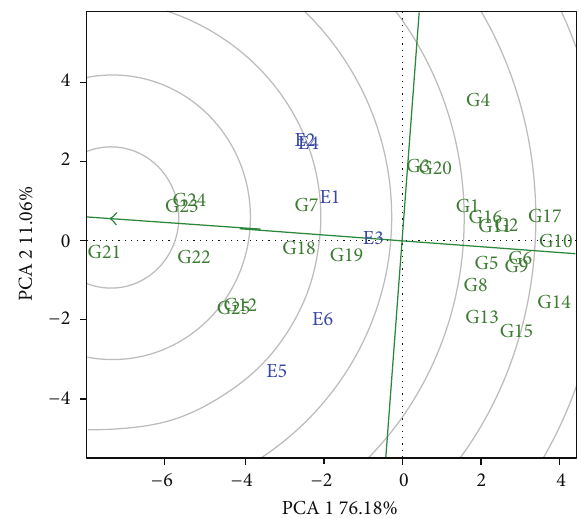
Figure 4: GGE biplot graph, with the distance of the 25 hybrids (numbered from G1 to G25) from the “ideal genotype”, in regard to grain yield (t ha −1 ). Concentric circles facilitate the exploratory analysis of the distances between the genotypes evaluated and the ideal genotype represented by the green